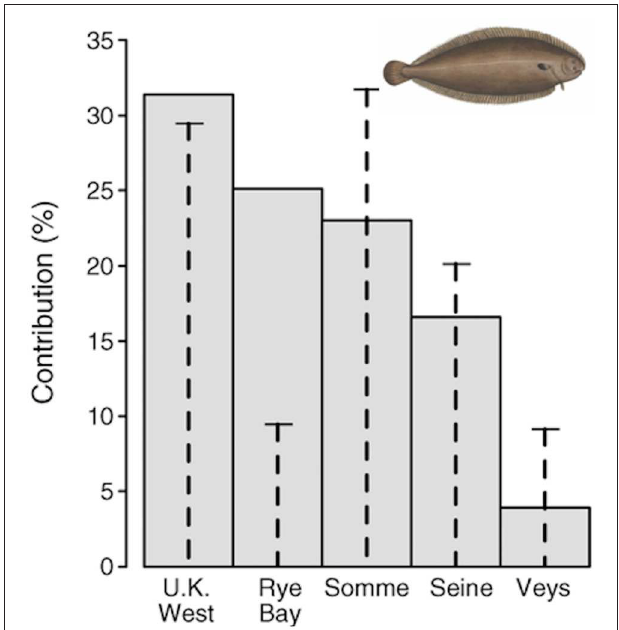
FIGURE 6 | Contribution of each nursery ground to the total recruitment of age-0 juveniles of common sole Solea solea in the Eastern Channel. Gray bars are the average contribution (calculated across all years) of each nursery to total recruitment. Vertical dashed lines indicate the surface area of each nursery as a percentage of the total surface area of nursery sectors, so that the difference between bars and dashed lines highlights the contrast in productivity. Figure reproduced with permission (Wiley and Sons license 4454871465571) from Rochette et al. (2013). Image from https://www. wpclipart.com/animals/aquatic/fish/F/flatfish/Common_sole__Solea_solea_2. png.html.